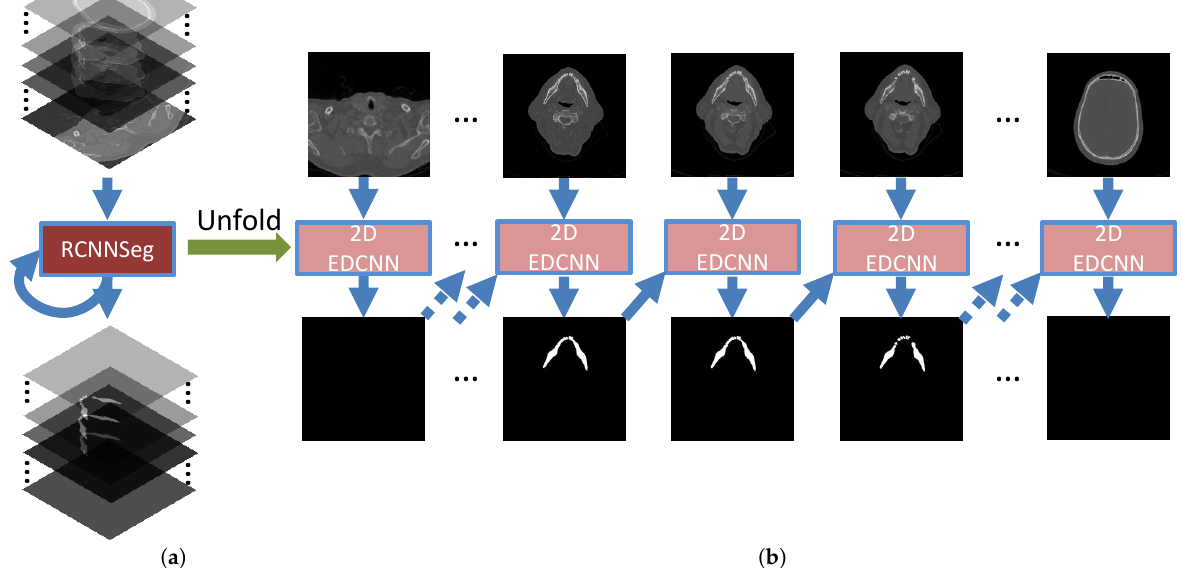
Figure 2. The overall graphic scheme of the proposed methods. The architecture of RCNNSeg with two components: ( a ) the RCNNSeg and its loss drawn with recurrent connections; ( b ) the same seen as a time-unfolded computational graph, where each node is now associated with one particular time